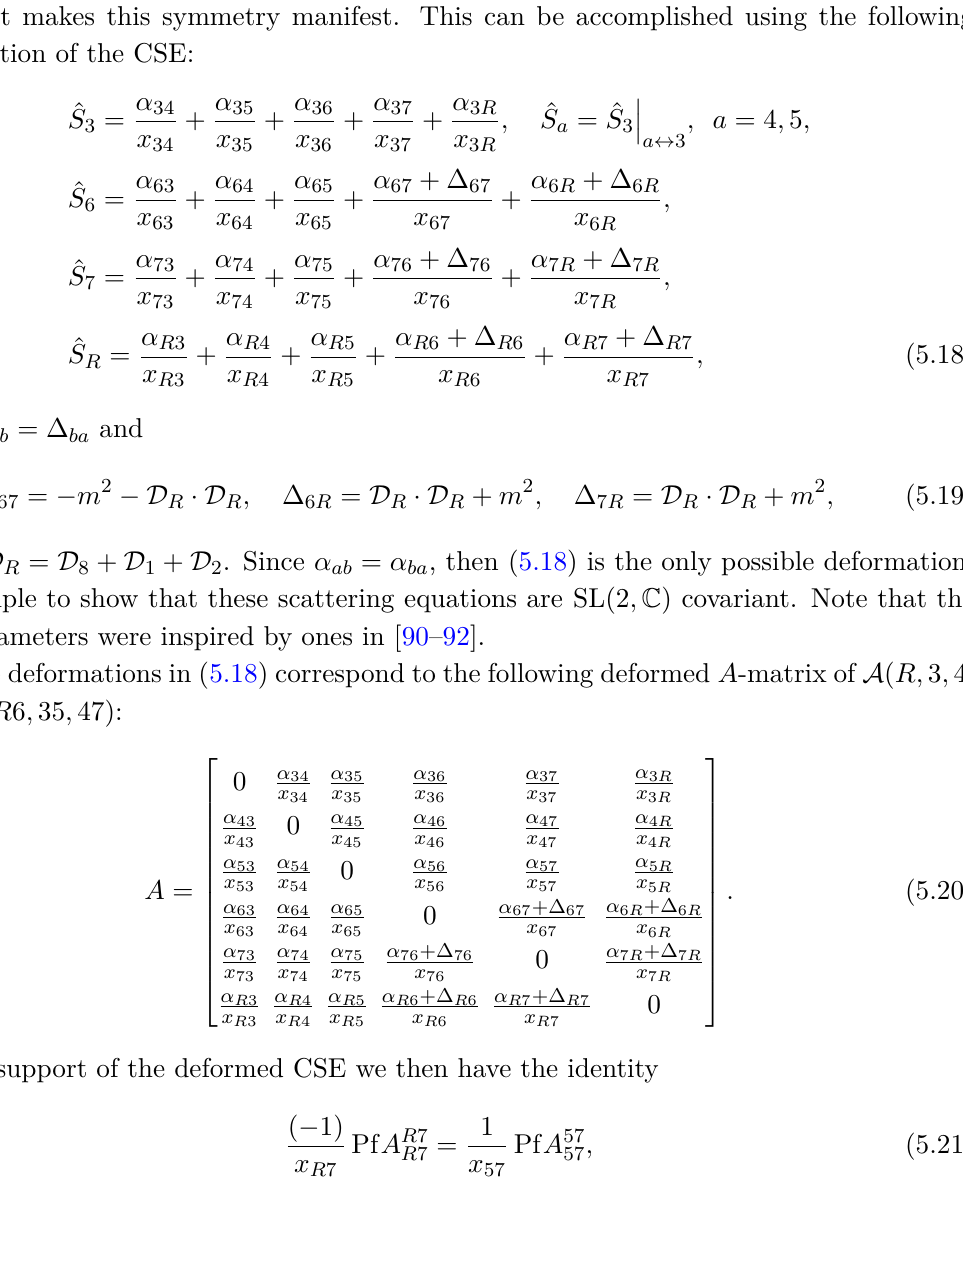
where Pf A 1 L and Pf A R 7 are given in equation (5.4). This factorization is depicted in 1 L R 7 figure